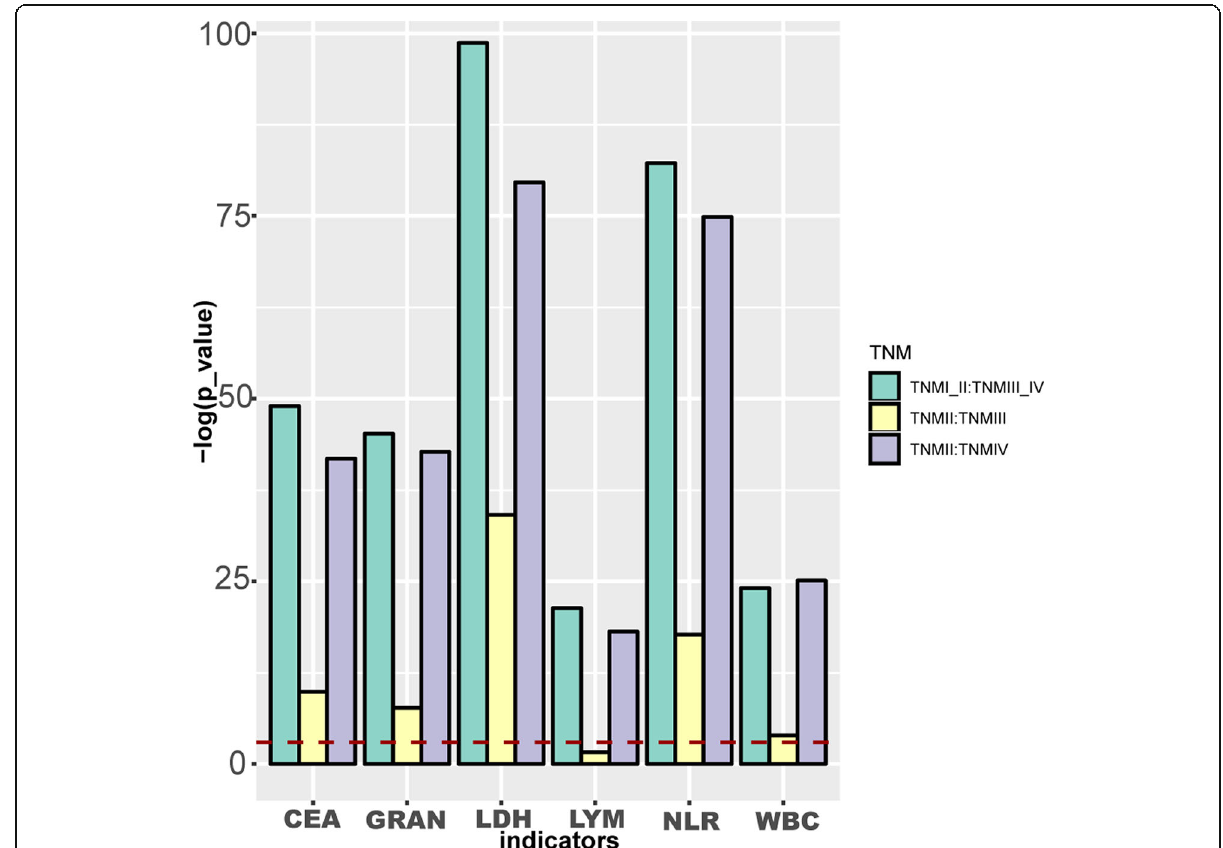
Fig. 1 Association of TNM stages and six clinical indicators. The higher the column in the graph, the more significant it is. The red line represents the threshold of p -value = 0.05